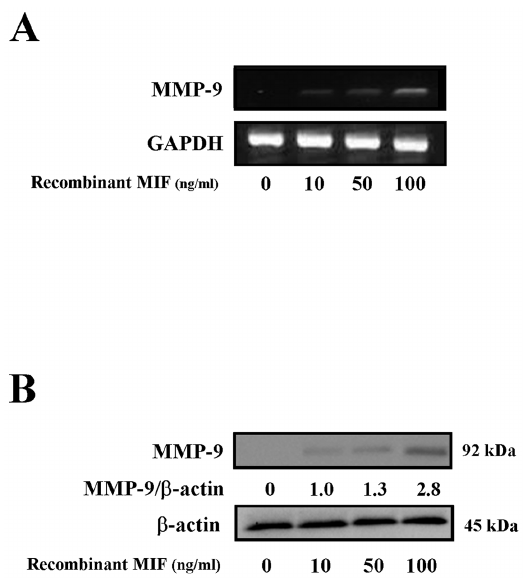
Figure 7. Effects of MIF on the acute UVB-induced expression and production of MMP-9 in neutrophils. Neutrophils (approxi- mately 90% purified) were pretreated with recombinant MIF at different concentrations (10, 50 and 100 m M) for six or 24 hours. (A) Cells were analyzed with RT-PCR of MMP-9. (B) Western blot analysis of the MMP-9 protein expression was then performed. The bands were quantified densitometrically and normalized to the level of b -actin. These experiments were repeated three times with similar